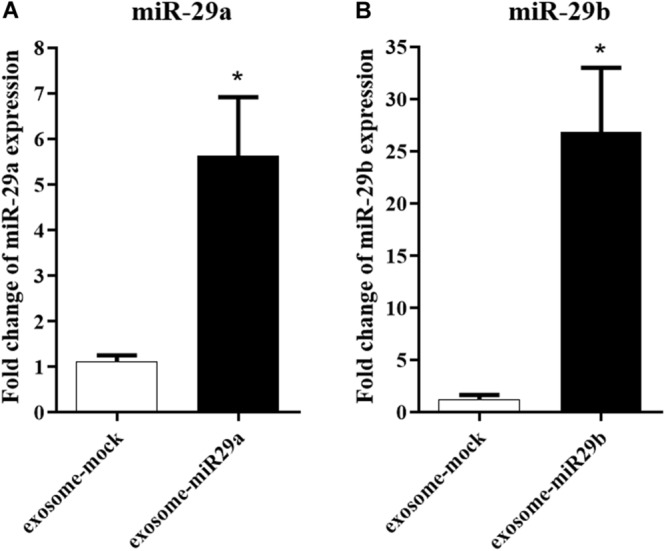
The packaging of miR-29a and miR-29b in exosomes isolated from HEK-293T cells. miR-29a (A) and miR-29b (B) levels were elevated in purified exosomes from HEK-293T cells, compared to the exosomes extracted from HEK-293T cells expressing mock vector, confirming miR-29a and miR-29b loading within exosomes. All data are presented as the mean ± SEM. * < 0.05 compared to the mock group.